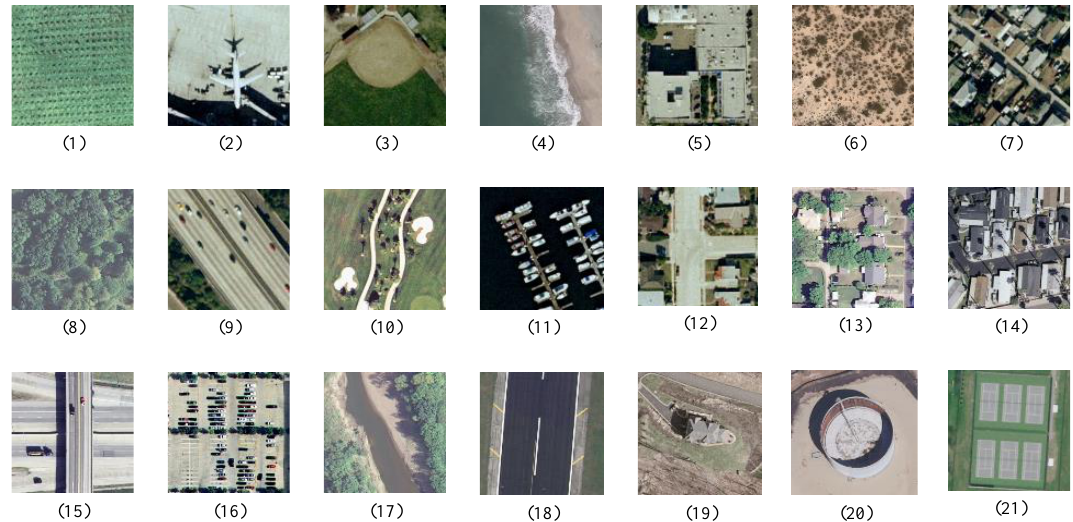
Figure 8. Representation of classes in the UC Merced dataset. (1) Agriculture. (2) Airplane. (3) Baseball diamond. (4) Beach. (5) Buildings. (6) Chaparral. (7) Dense residential. (8) Forest. (9) Freeway. (10) Golf course. (11) Harbor. (12) Intersection. (13) Medium residential. (14) Mobile home park. (15) Overpass. (16) Parking lot. (17) River. (18) Runway. (19) Sparse residential. (20) Storage tanks. (21) Tennis